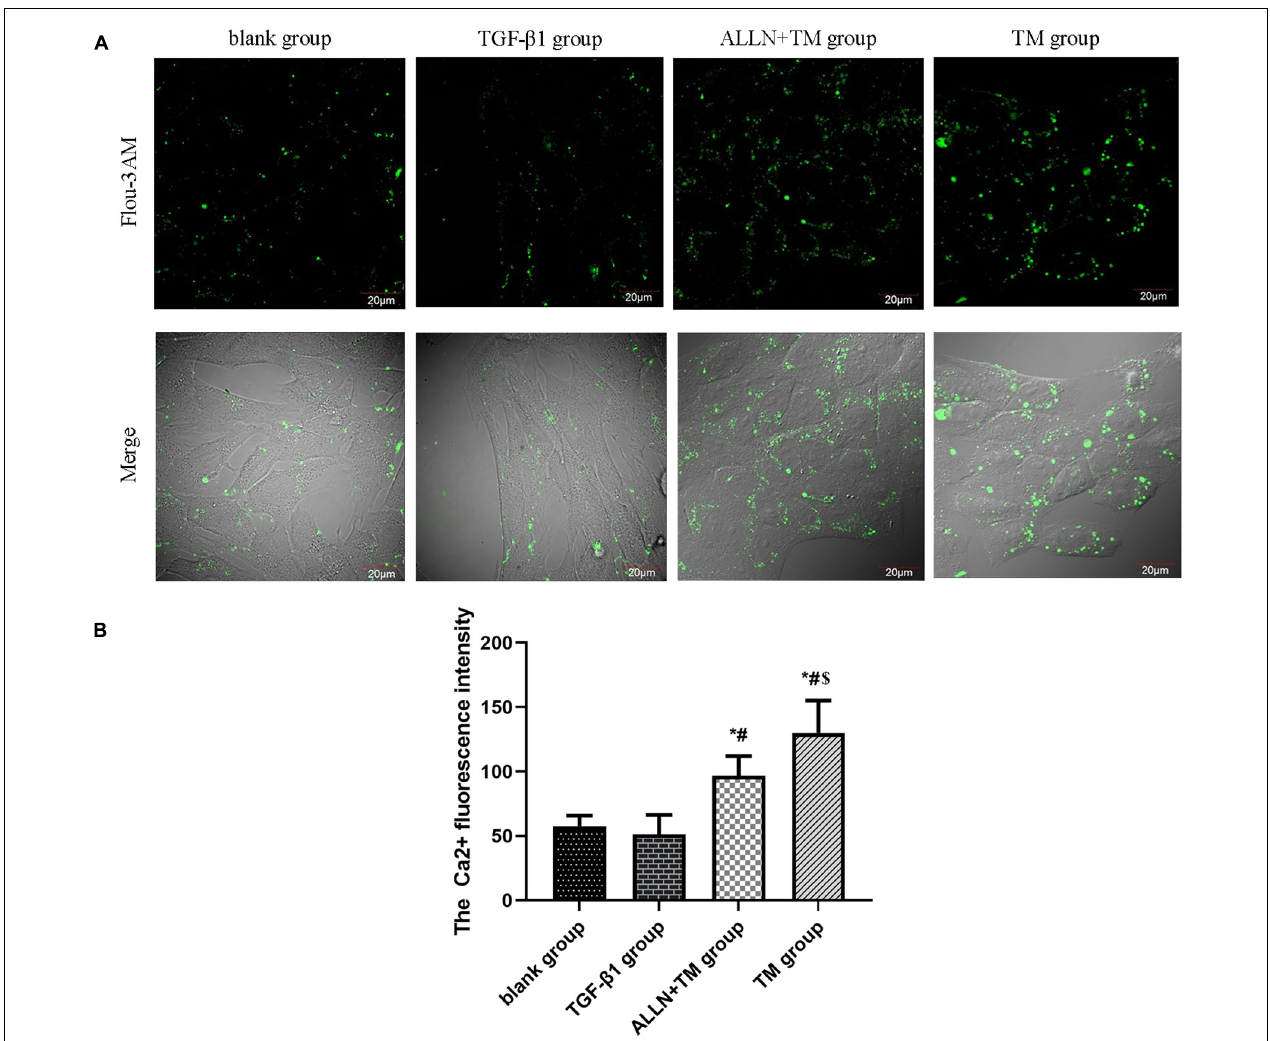
FIGURE 5 | The changes in Ca 2 + fluorescence intensity in HSC. The changes in Ca 2 + concentration in each group were detected by a laser scanning confocal microscope. (A) Green fluorescence represents the Ca 2 + fluorescence intensity in HSC. (B) Columns represent Ca 2 + fluorescence intensity in HSC (* p < 0.05 compared with the blank group; # p < 0.05 compared with the TGF- β 1 group; $ p < 0.05 compared with the ALLN + TM